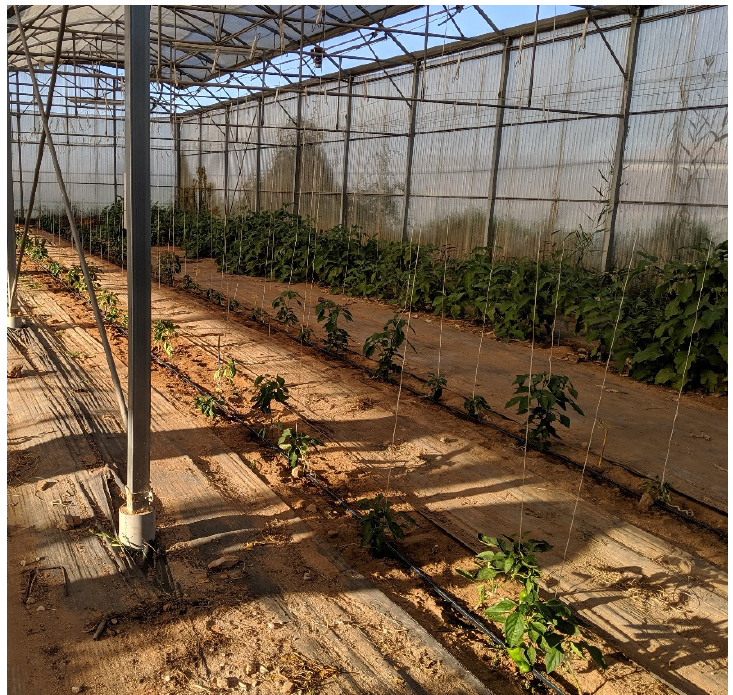
Figure 1. Satellite image of the experimental station of Agròpolis (The red box indicates the specific location of the research greenhouse).